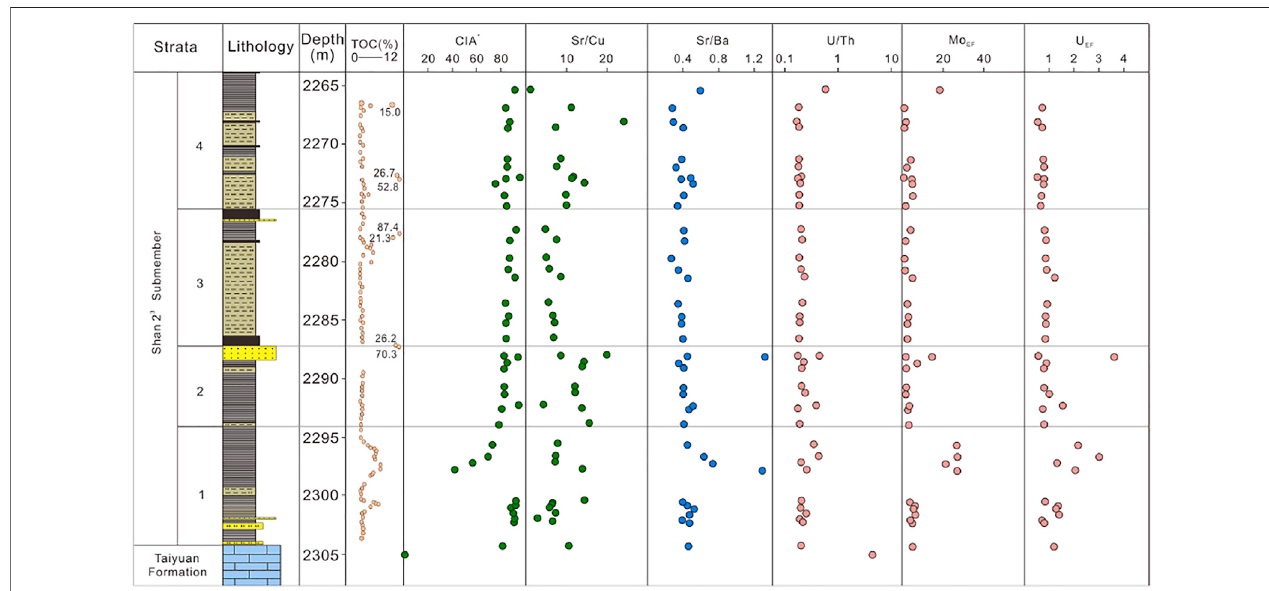
FIGURE 6 | TOC and trace elements ratios for Shanxi Formation Shan 2 3 Submember shale from the studied well in the Eastern Ordos Basin.